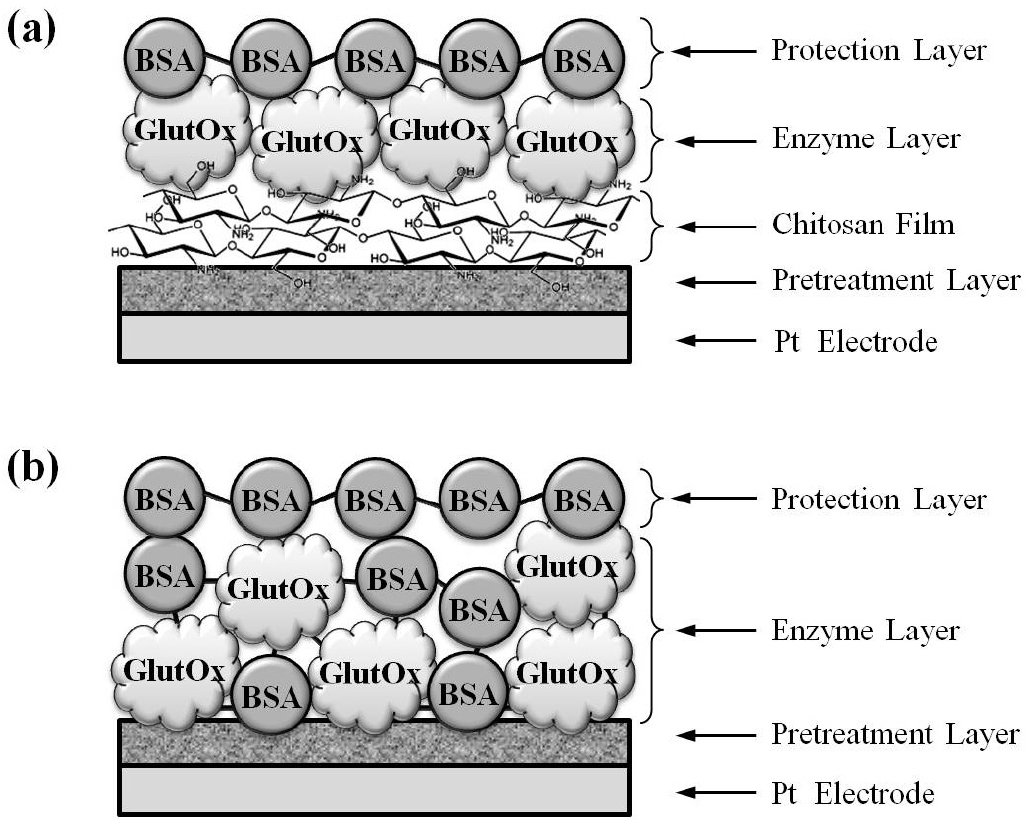
Figure 6. The schematic configuration of the glutamate sensor prepared by ( a ) Method 1 (immobilization of glutamate oxidase by adsorption on the electrodeposited chitosan) and ( b ) Method 2 (immobilization of glutamate oxidase by crosslinking with the